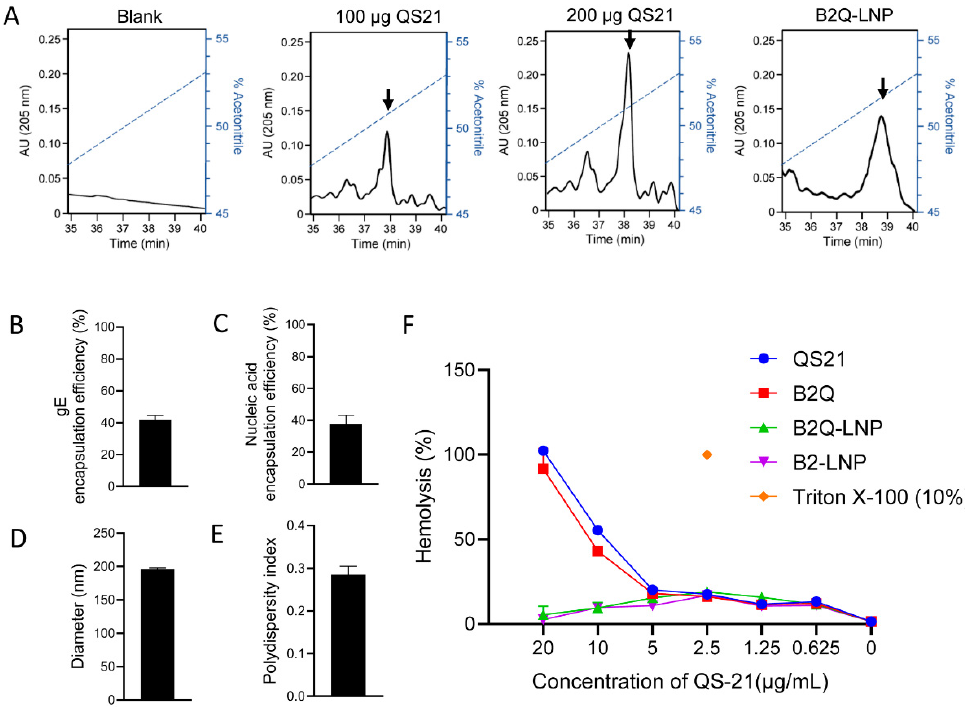
Figure 4. Characterization of the lipid nanoparticle (LNP)-CpG-QS21 adjuvanted vaccine and hemolytic assay. ( A ) The encapsulation efficiency analysis of QS21 by high performance liquid chromatography. Flow gradient is shown with dotted lines and eluted QS21 is indicated by arrows. ( B ) The encapsulation efficiency of protein gE. ( C ) The encapsulation efficiency of CpG ODNs. ( D ) diameter. ( E ) polydispersity index. ( F ) hemolysis analysis. Experiments were repeated three times, and the data are shown as the mean ± SD.